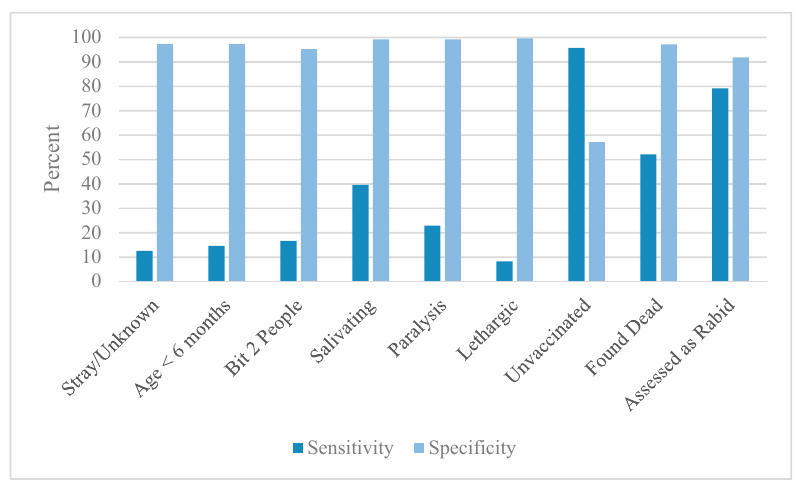
Figure 2. Sensitivity and specificity of the relevant variables.